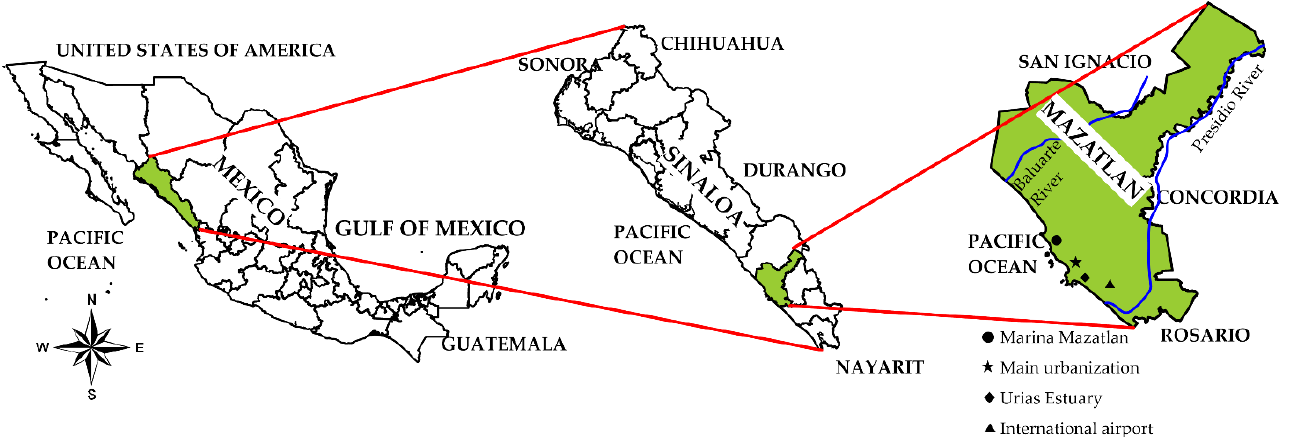
Figure 1. Geographic location of Mazatlan in Sinaloa, Mexico.